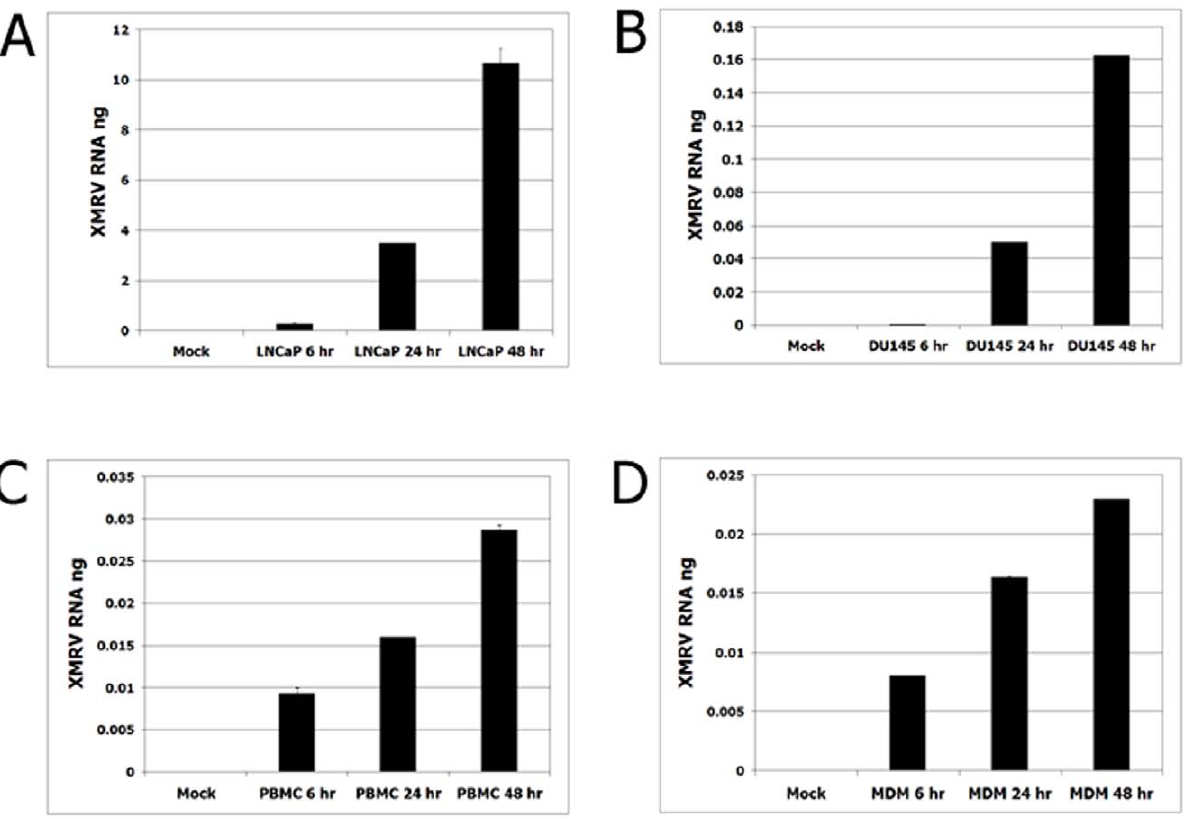
Figure 1. Quantitative-PCR analysis of XMRV infection. Total mRNA from (A) LNCaP, (B) DU145, (C) PBLs and (D) MDM cells either mock- or virus-treated were subjected to RT-PCR using the gag primers for detecting XMRV infection. GAPDH primers were used as endogenous controls. As evident, XMRV was able to infect all 4 cell types with substantial increase in infection by the 48 h time point.